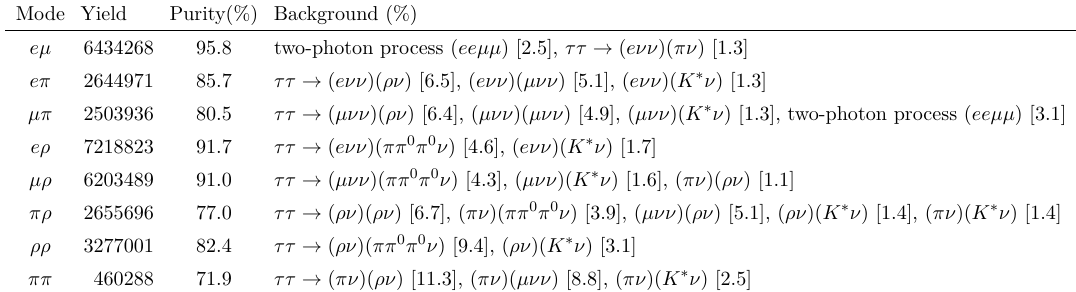
Table 1 . Yield, purity, and dominant backgrounds for each selected mode. The values in square brackets indicate the expected background rates in